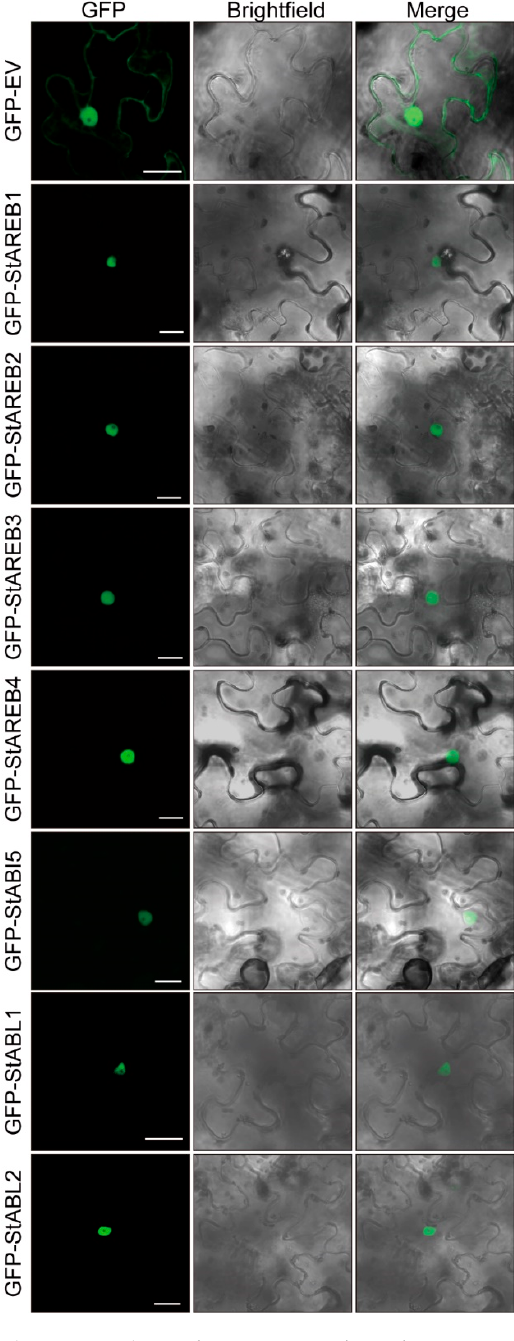
Figure 3. Subcellular localization analysis of potato AREB/ABF/ABI5 members. The GFP alone and GFP-fusion proteins were transiently expressed in N. benthamiana leaves via agroinfiltration and the images of epidermal cells were taken at 60 hpi by CLSM. Green color indicates that GFP alone is localized in both the cytoplasm and nucleus, AREB/ABF/ABI5 members are mainly localized in the nucleus. Bars = 20 μ m.